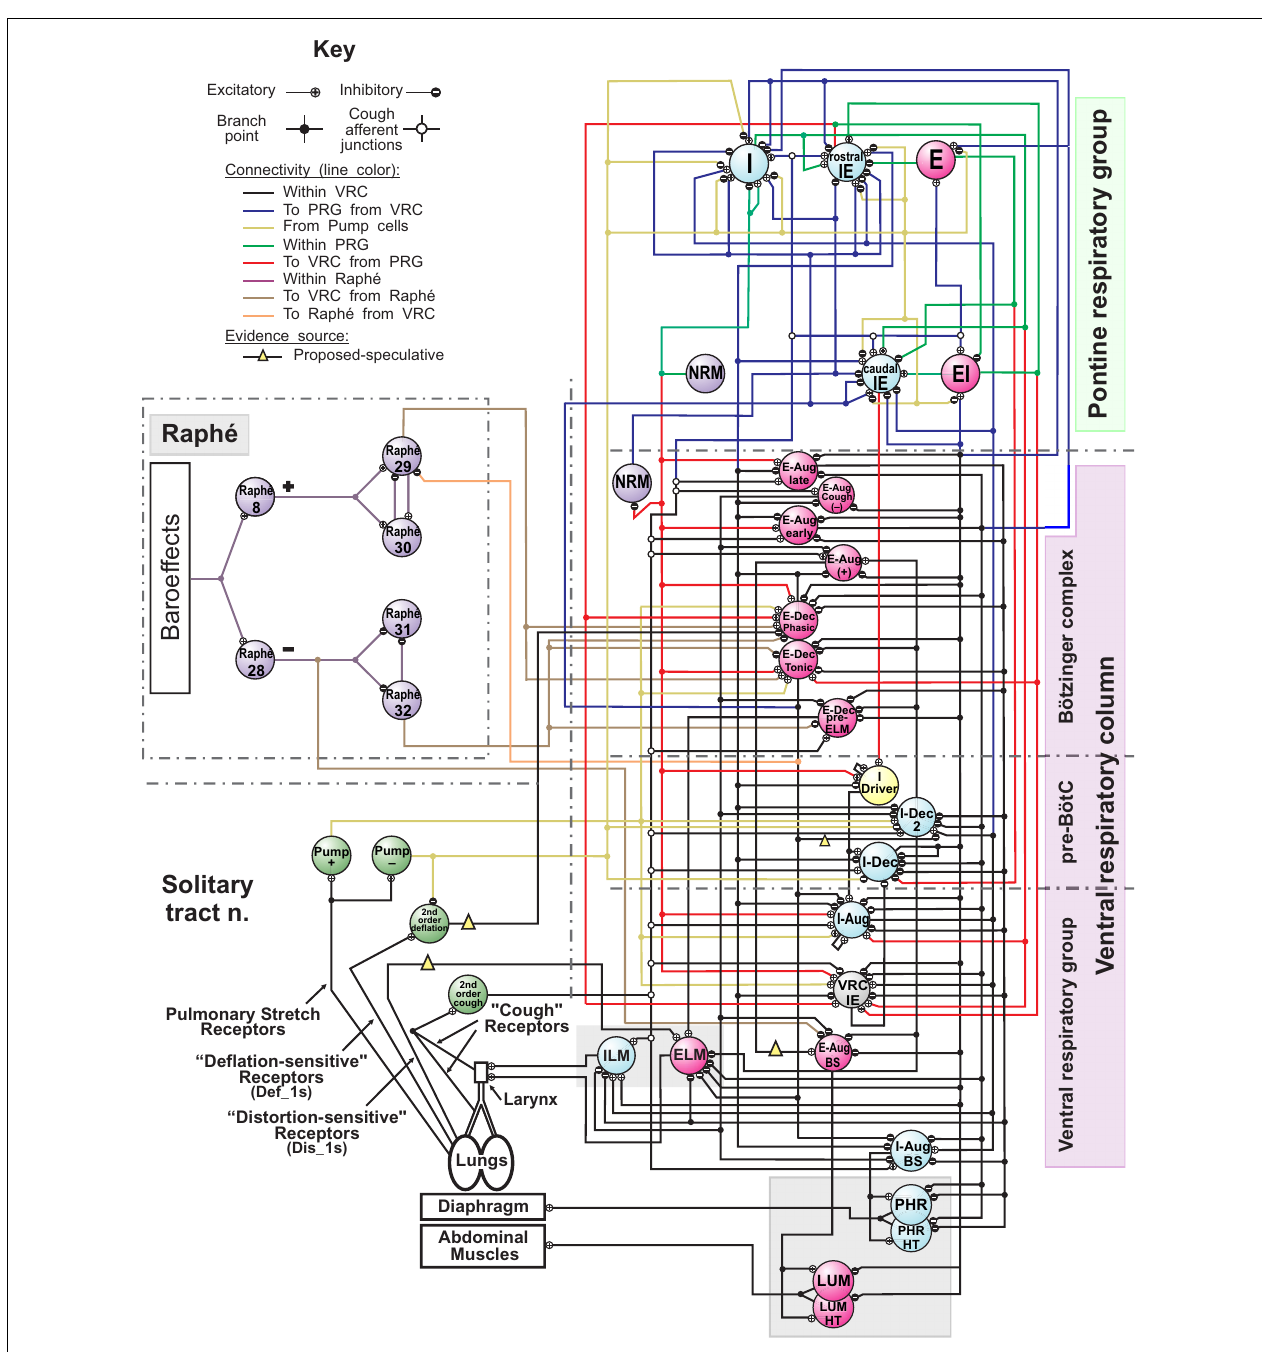
activity patterns, respectively, during the indicated phase (I-inspiratory; E-expiratory) of maximum firing rate. BS, bulbo-spinal; ELM, expiratory laryngeal motoneurons; EI, neurons with a peak firing rate during the E-to-I phase transition; IE, neurons with a peak firing rate during the I-to-E phase transition; ILM, inspiratory laryngeal motoneurons; NRM, non-respiratory-modulated neurons.Two phrenic motor neuron populations with different threshold ranges innervated the diaphragm (PHR, PHR-HT: high threshold); two lumbar motor neuron populations activated the abdominal muscle (LUM, LUM-HT: high threshold). I-Dec_2, second inhibitory I population in theVRC (e.g., see Ott et al., 2012); Lung Def_1s, Lung Dis_1s, Deflation 2nd order: lung deflation-sensing neuronal circuit elements. See text for further